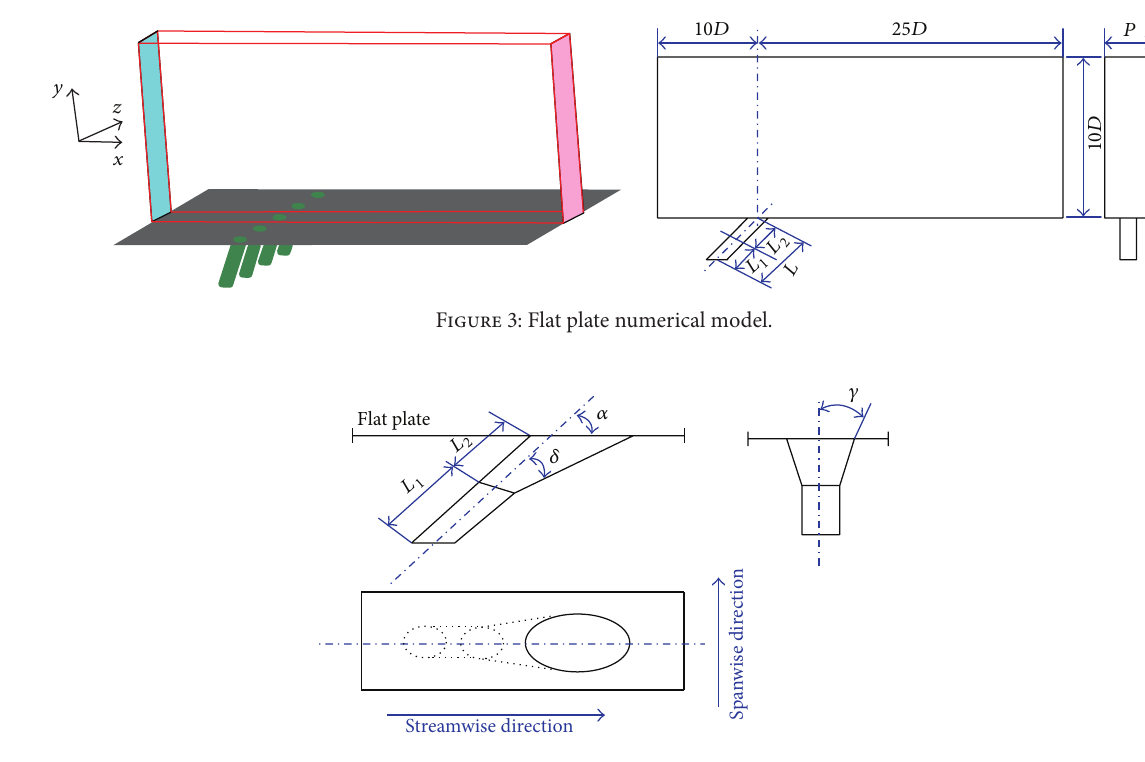
Figure 4: Generalized cooling hole configuration: LFDSA